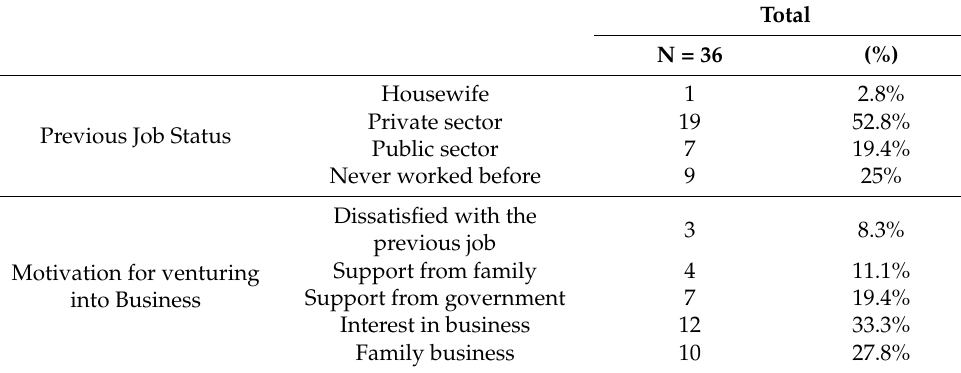
Table 2. Motivation to venture into